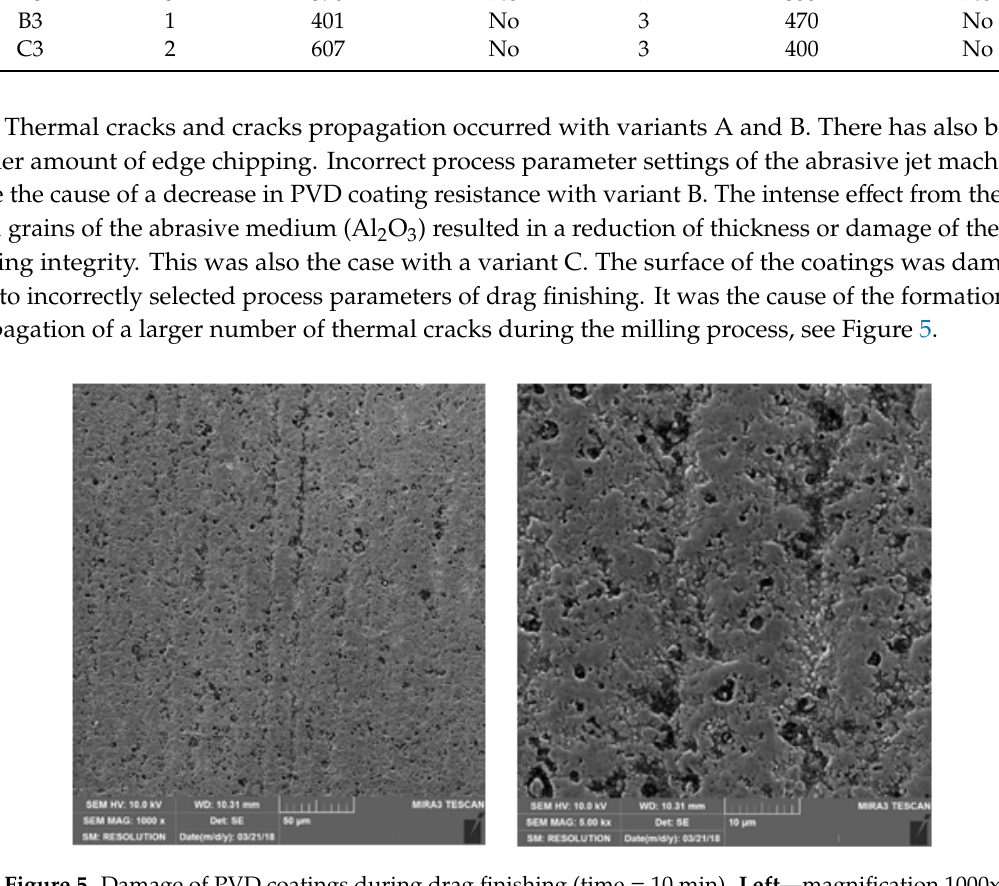
Figure 5. Damage of PVD coatings during drag finishing (time = 10 min). Left—magnification 1000x; right—magnification 5000x.